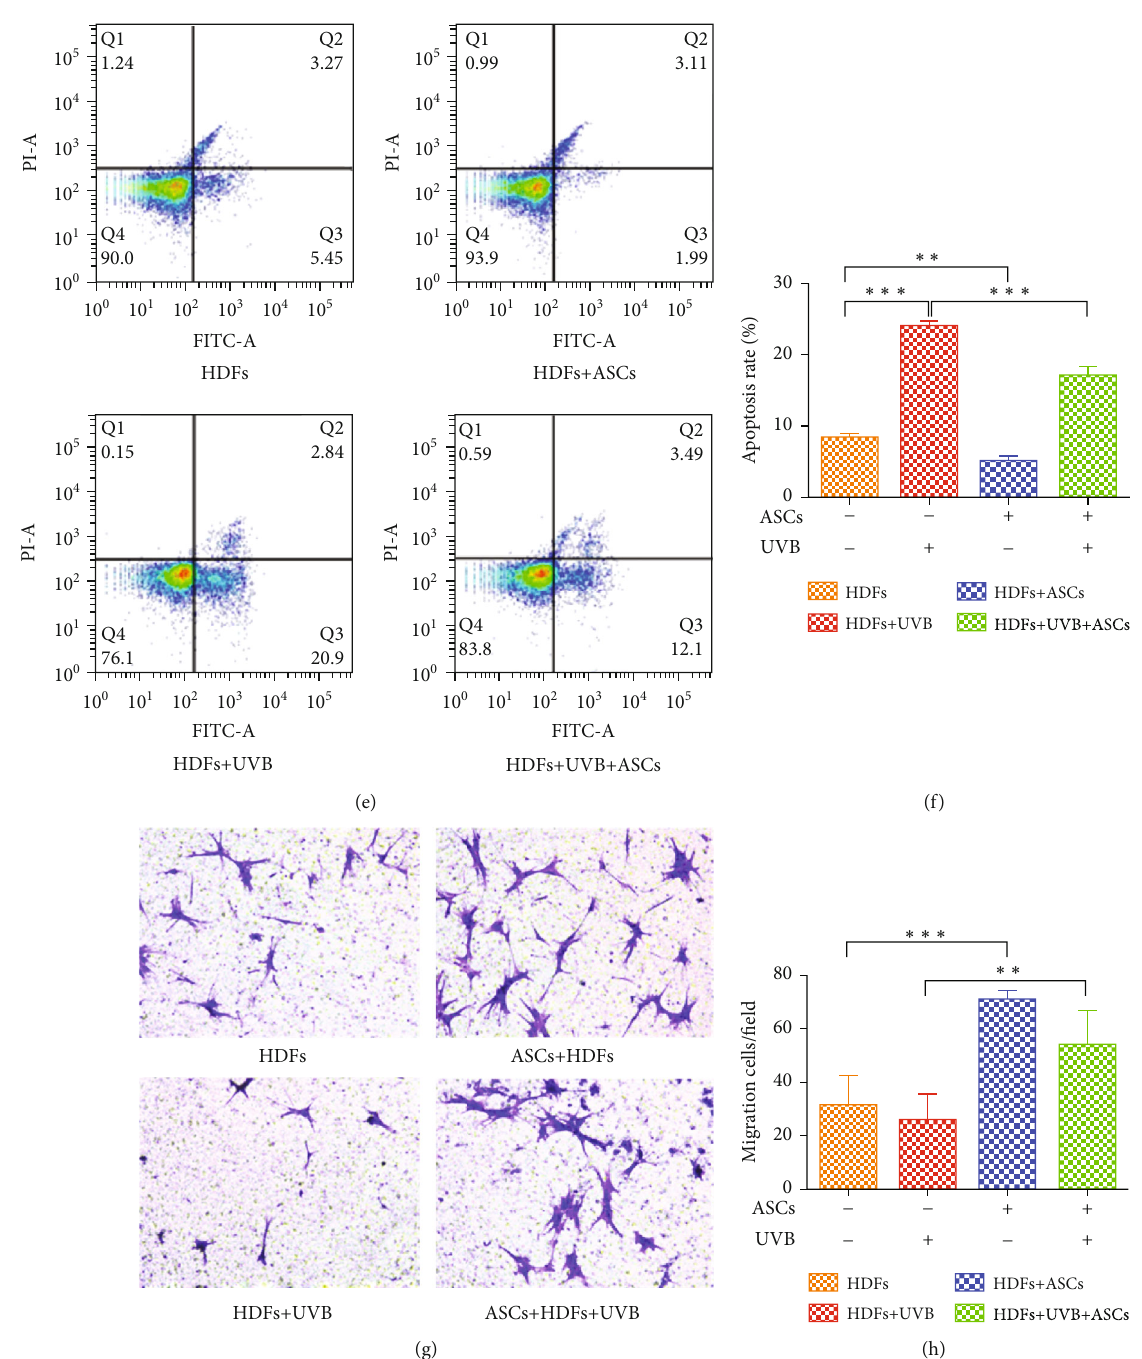
Figure 1: Assessment of the functions of HDFs cocultured with ASCs. (a) Schematic illustration of the cell experiment. (b) Representative images of senescence-associated β -galactosidase (SA- β -gal) staining. Positive blue staining of SA- β -gal appeared in senescent HDFs. (c) The average percentage of SA- β -gal-positive cells was quanti fi ed. Five random fi elds were selected for counting. (d) Proliferation of HDFs was assessed by CCK-8 assays. (e) HDF apoptosis was measured by FACS analysis after Annexin V-FITC/PI staining. (f) The apoptosis rates of HDFs were quanti fi ed. (g) Representative images of migrated HDFs (magni fi cation, × 200). (h) The number of migrated HDFs per fi eld. Five random fi elds were selected for counting. All experiments were independently conducted in triplicate, and the values are expressed as the mean ± SD . ( ∗ p < 0 : 05 , ∗∗ p < 0 : 01 , ∗∗∗ p < 0 : 001